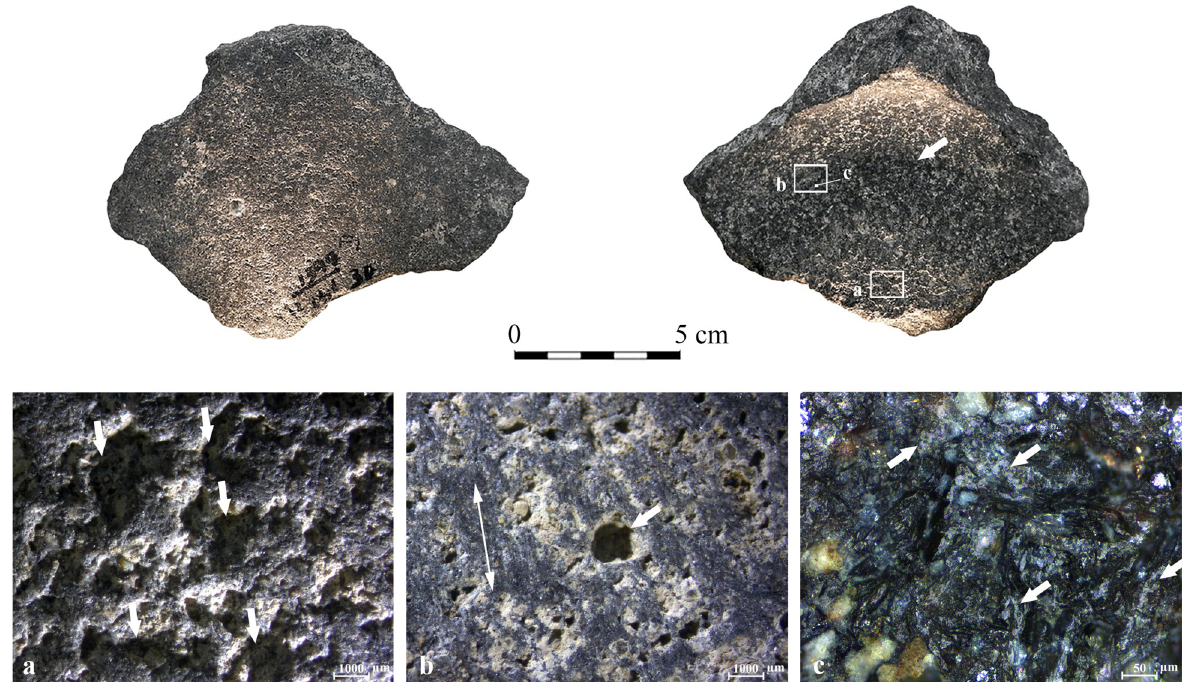
Fig 12. Archaeological vessel TBY37 from the Early Bronze Age I of Tel Bet Yerah, with surface darkening marked by an arrow. (a) Clear pecking marks on the elevated center shown by arrows (10x); (b) Flat leveled striated surface of the circumferential depression with a pit with sharp edges marked by an arrow. The orientation of the striations is marked by a double-headed arrow (10x); (c) A surface showing polished surfaces marked by arrows, exhibiting a reticular pattern (200x).